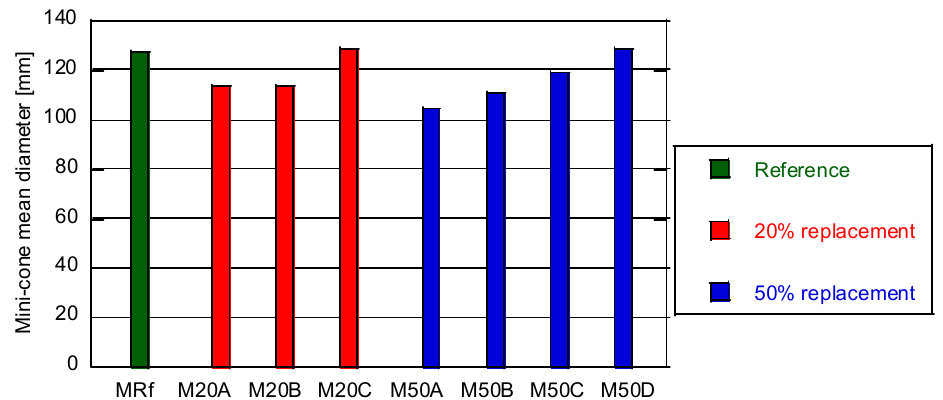
Figure 14. Mortar workability, slump table test results.